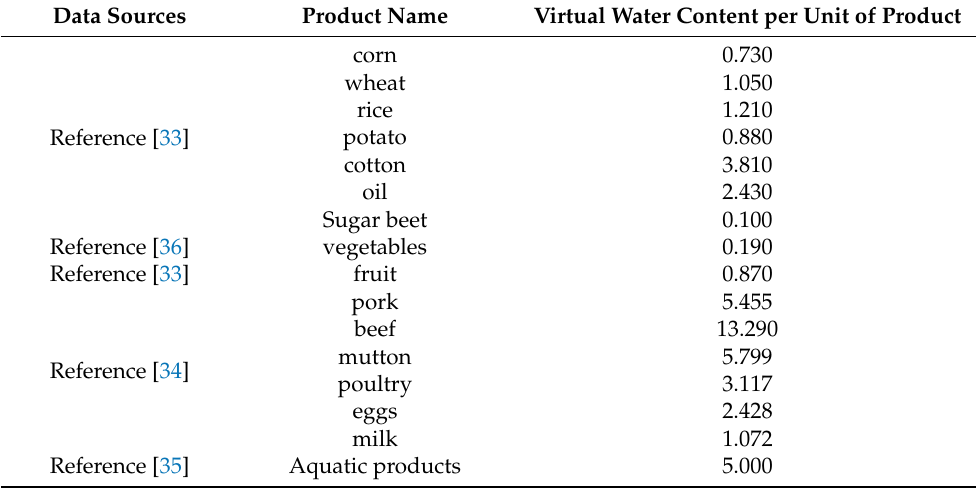
Table 1. Virtual water content of main products and source Unit: m 3 /kg.